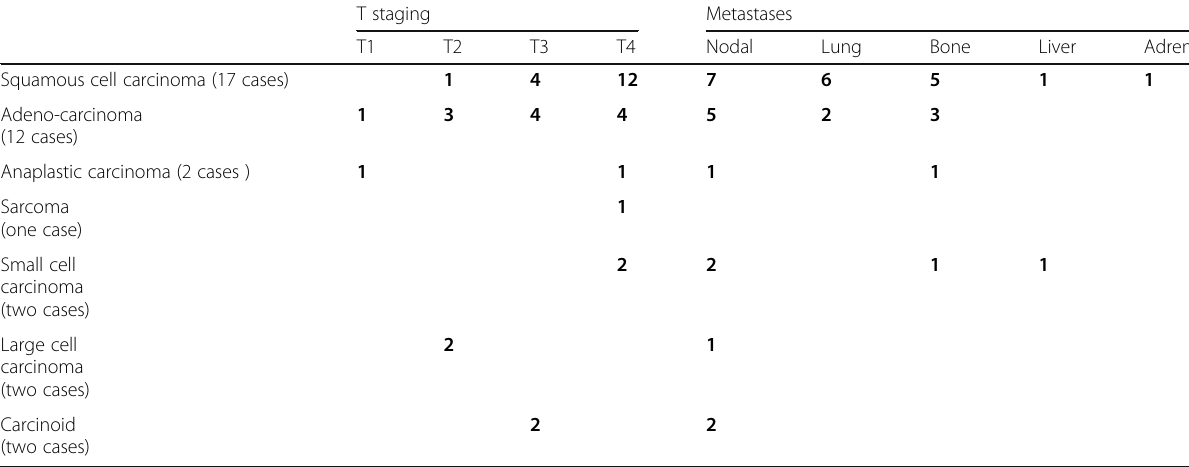
Table 2 Local staging of the